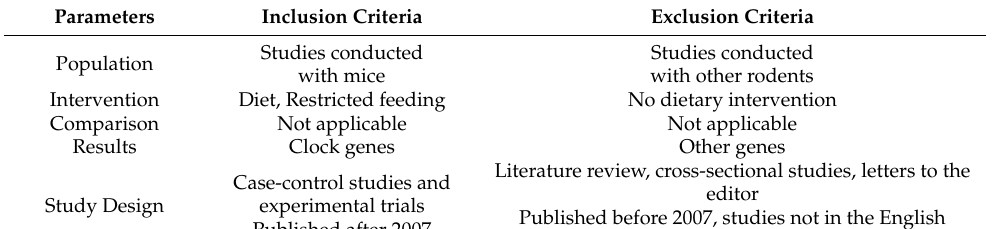
Table 1. Inclusion and exclusion criteria used according to PICOS.